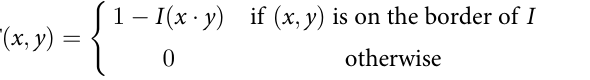
where, I is the binary image and F is the output image. F will be 0 everywhere apart from the image border, which is denoted as 1 − I. Finally, to draw the largest contour, cv2.drawContours function is utilized. Here, the first parameter is where the contour will be drawn; the second parameter is the list of contours. As we have just one largest contour, we have passed a list of single contour. The third parameter is the index of target contour to be drawn, for our case ‘0’ is set, as we have just one index in the contour list. The fourth parameter is the color of mark- ing. For our case, the value is (255,255,255). Therefore, the contour will be drawn with a pixel value of (255,255,255). The last parameter is the thickness of drawing the contour border. We have filled the contour area with a pixel value of (255,255,255). Therefore, cv2.FILLED param- eter value is used to fill the entire area of the contour with a value of (255,255,255) and a binary mask is returned as our final segmentation mask. cessed image. The process of deriving the final mask and the segmented ROI is illustrated in Fig 15. After implementing the algorithms associated with the segmentation process, it can be observed that the ROIs are successfully extracted as shown in Fig 16. Table 5 represents all the selected parameter values for the algorithms associated with the segmentation process which are demonstrated above.